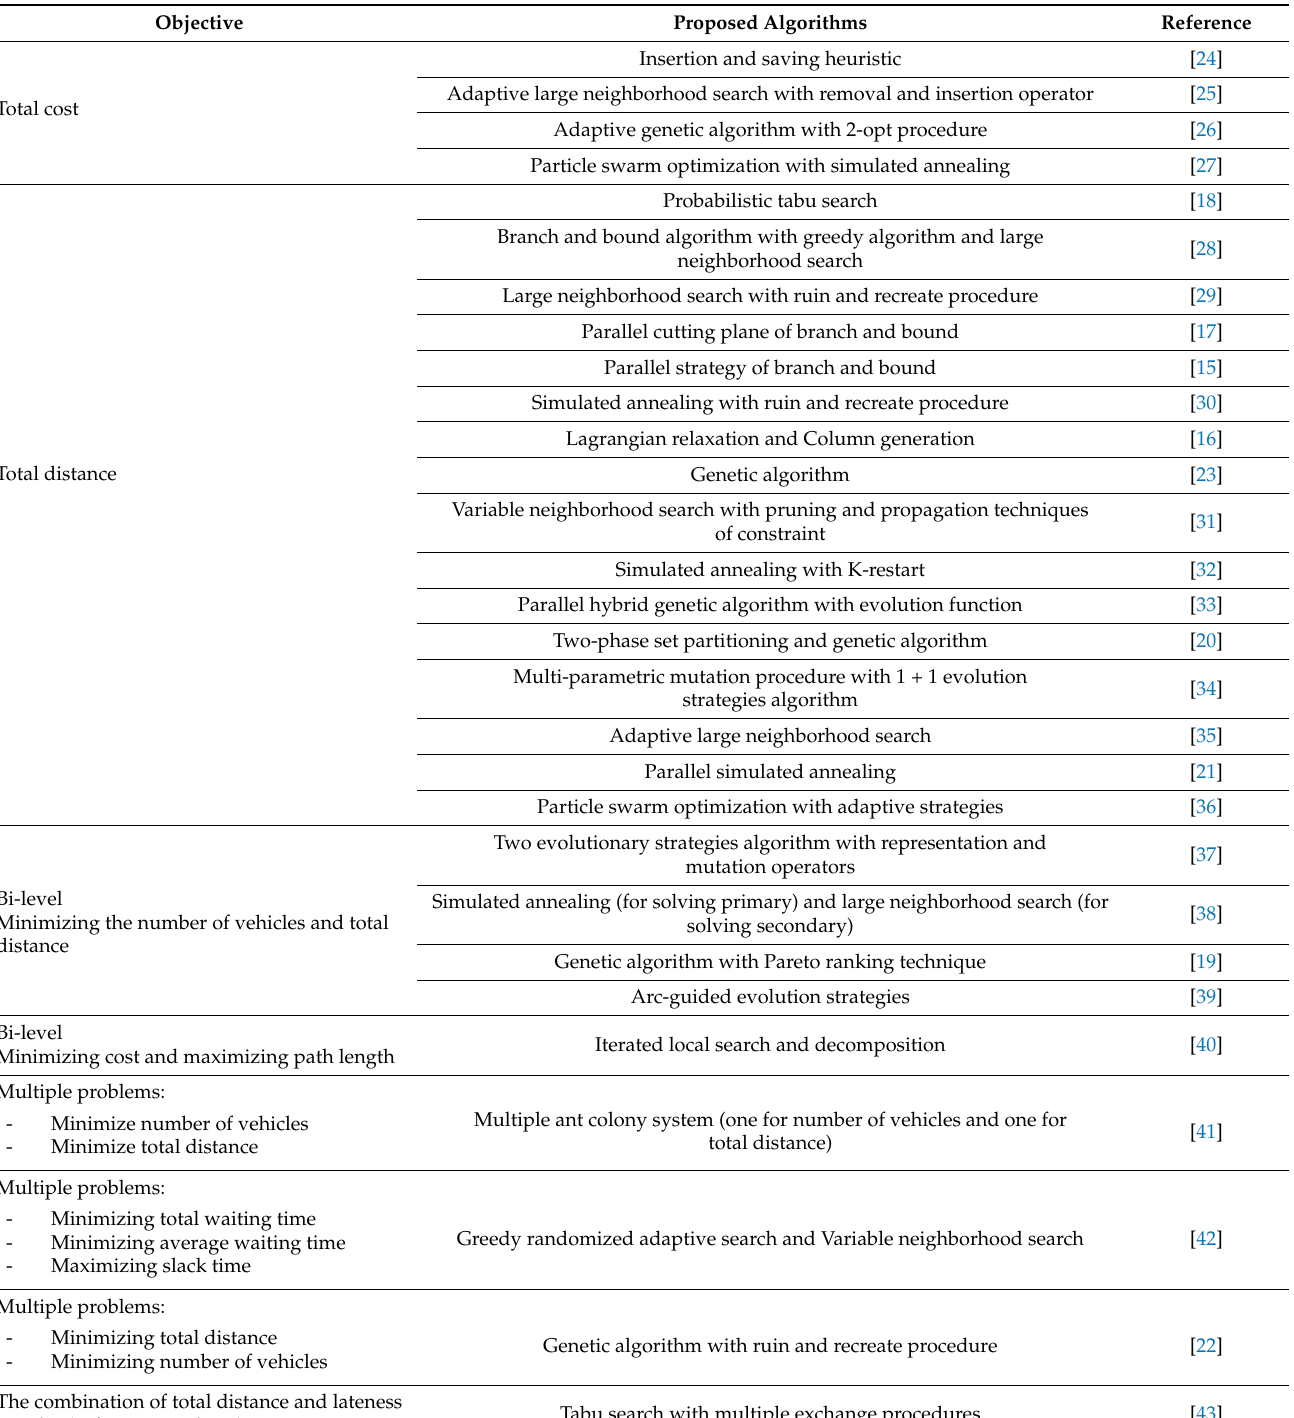
Table 2. Literature review for VRPTW with various objective functions and their proposed